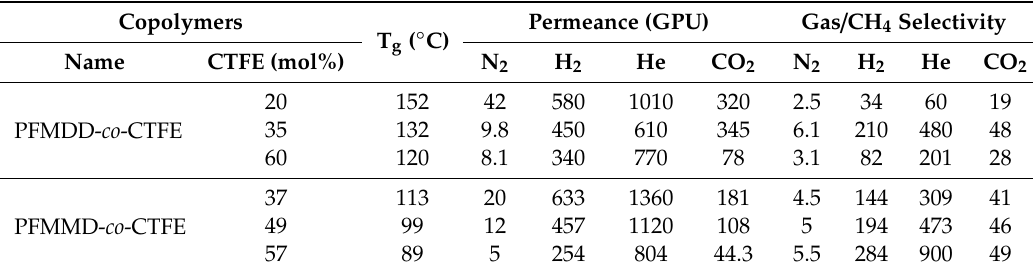
Table 6. Physical Properties of PFMMD- co -CTFE and PFMMD- co -CTFE and Gas Transport Properties of Their Thin Film Composite Membranes at 22 ◦ C